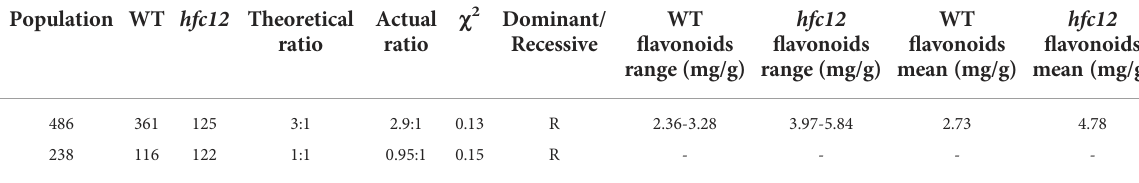
TABLE 1 Genetic analysis and fl avonoids content of wax gourd hfc12 .